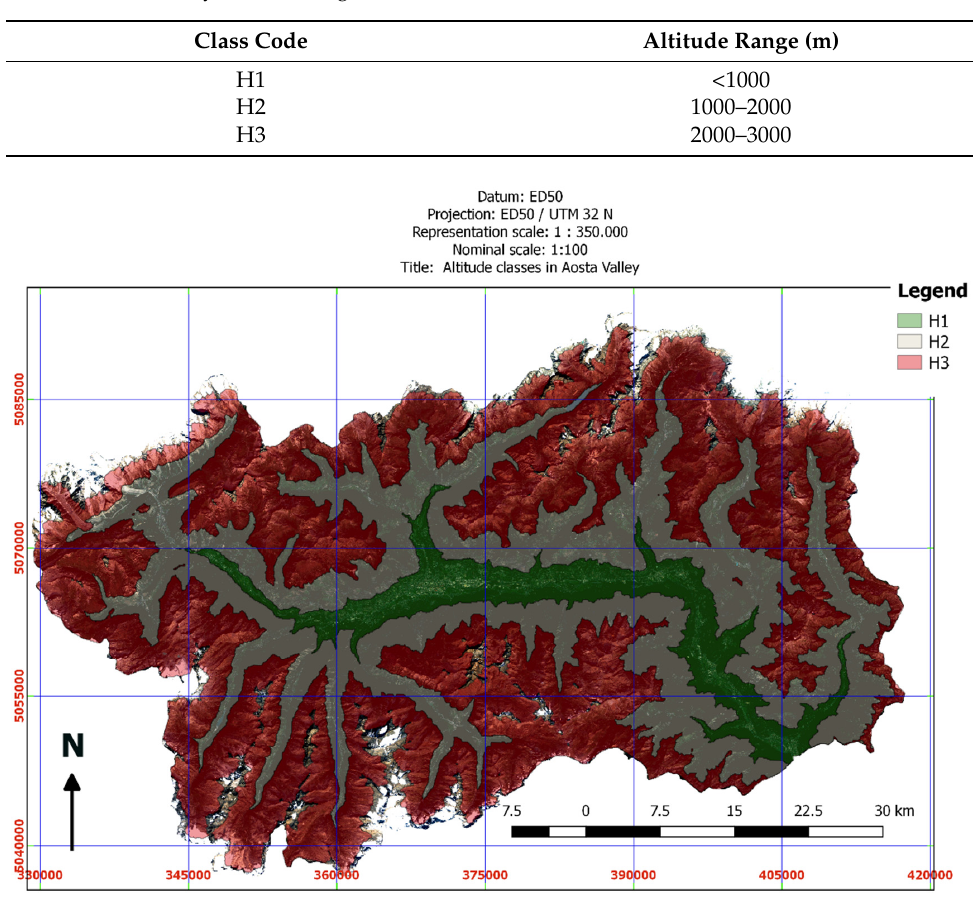
Table 3. Aosta Valley altitude ranges considered.